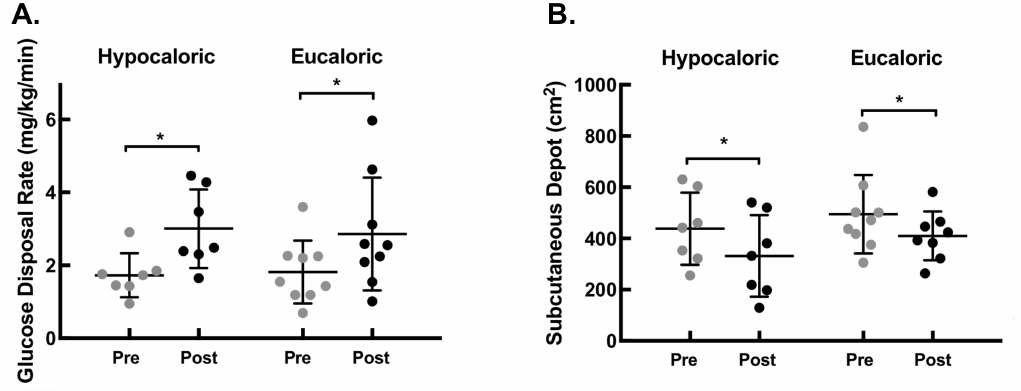
Figure 2. ( A ) Individual glucose disposal rates during 90–120 min time increment of euglycemic-hyperinsulinemic clamp before and after the 12-wk lifestyle intervention, which increased in both hypocaloric and eucaloric groups. Group average denoted by horizontal line, with standard deviation bars. ( B ) Individual computed tomography-measured subcutaneous fat depots before and after 12-wk lifestyle intervention, which decreased in both hypocaloric and eucaloric groups. Group average denoted by horizontal line, with standard deviation bars. * indicates p <